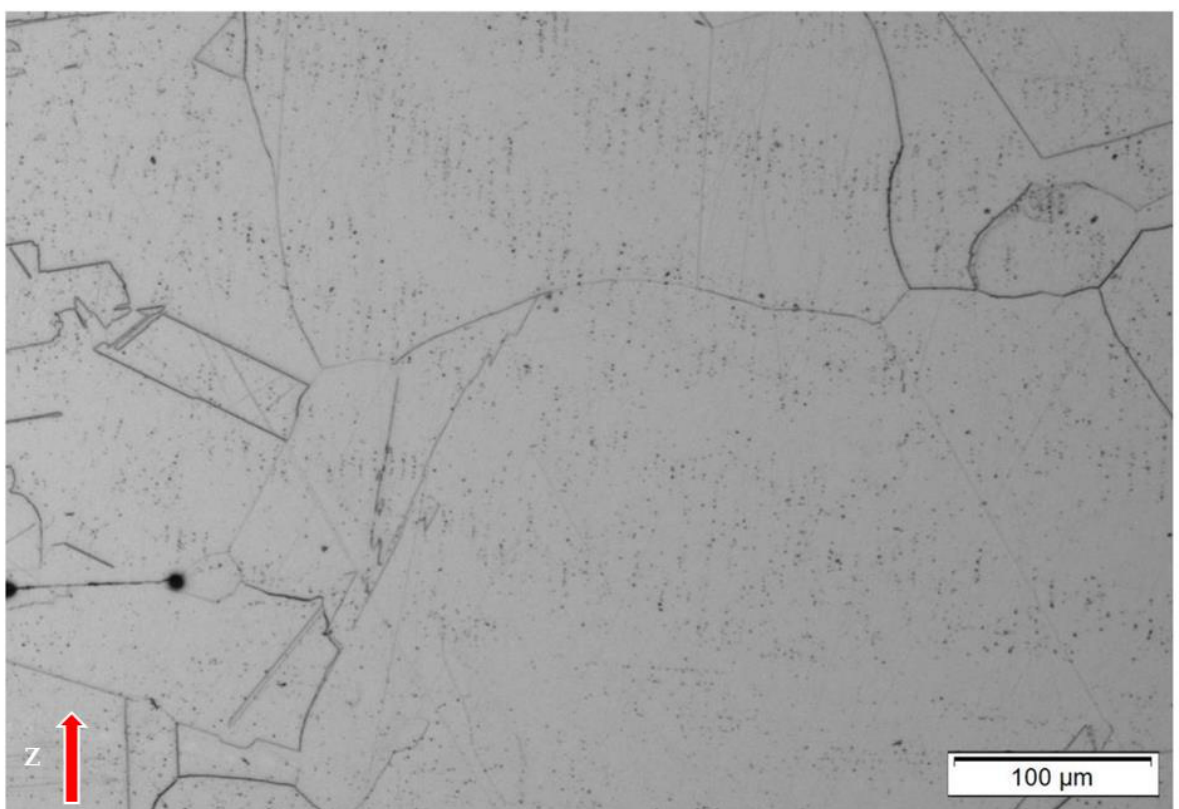
Figure 9. LW-DED raster heat-treated optical microscope image. Higher magnification showing pre- cipitates (dark spots).